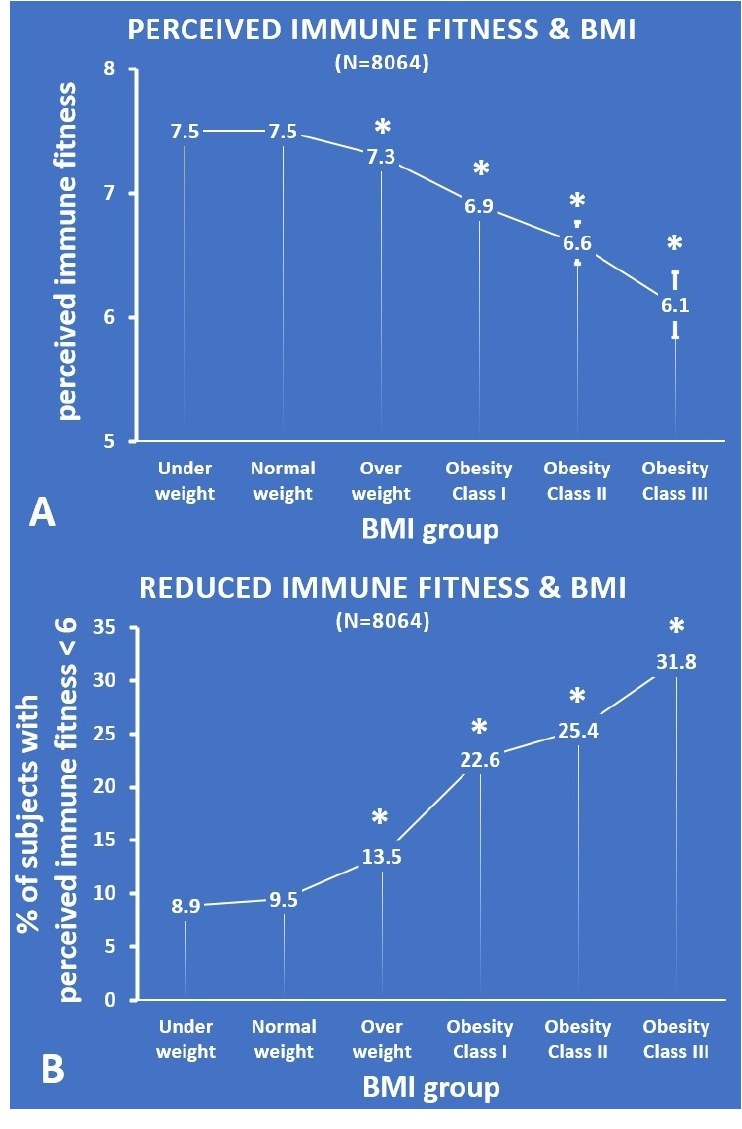
Figure 1. Momentary perceived immune fitness according to BMI group. ( A ) Each BMI group’s mean (SE) momentary perceived immune fitness score; ( B ) the percentage of subjects with a momentary perceived immune fitness score < 6. Significant differences ( p < 0.01, after Bonferroni’s correction) compared with the normal weight group are indicated by *. Abbreviation: BMI = body mass index.